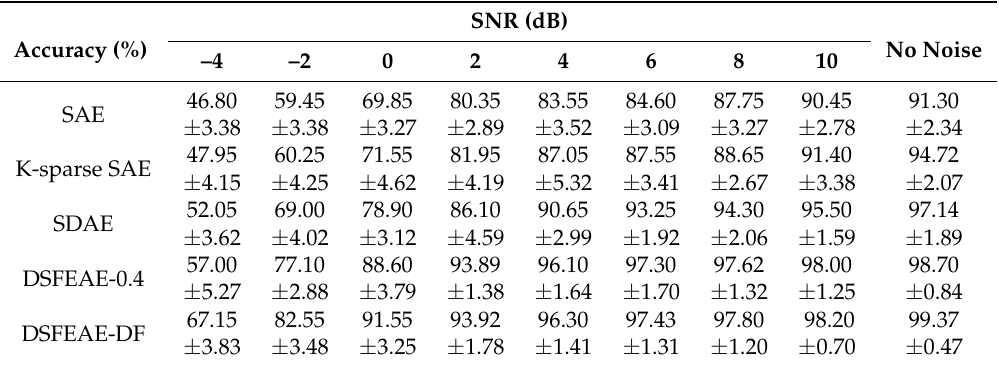
Table 2. Fault diagnosis